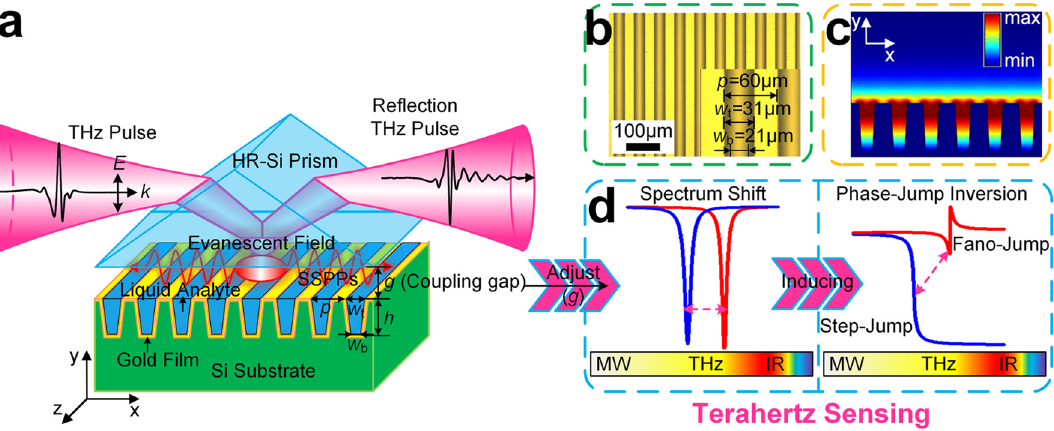
Figure 1: Schematic working principle of the phase readout plasmonic sensor. (a) Schematic diagram of the proposed evanescent wave plasmonic sensor with spoof plasmon surface (SPS) consisting of periodic grooves array. Grooves are of period p , top width w t , bottom width w b , and depth h . g is the coupling gap between the HR-Si prism base and the surface of SPS. The SPP supported on the SPS can be excited through the evanescent fi eld generated by the total internal re fl ection of THz beam. (b) Optical microscopy image of corrugated metallic surfaceswith p =60 μ m, w t =31 μ m, w b =21 μ mand h =90 μ m.(c)Theelectric- fi elddistributionsfortheSPSundersurfaceplasmonresonance (SPR). (d) The coupling gap controlled terahertz resonant sensing through monitoring the phase-jump